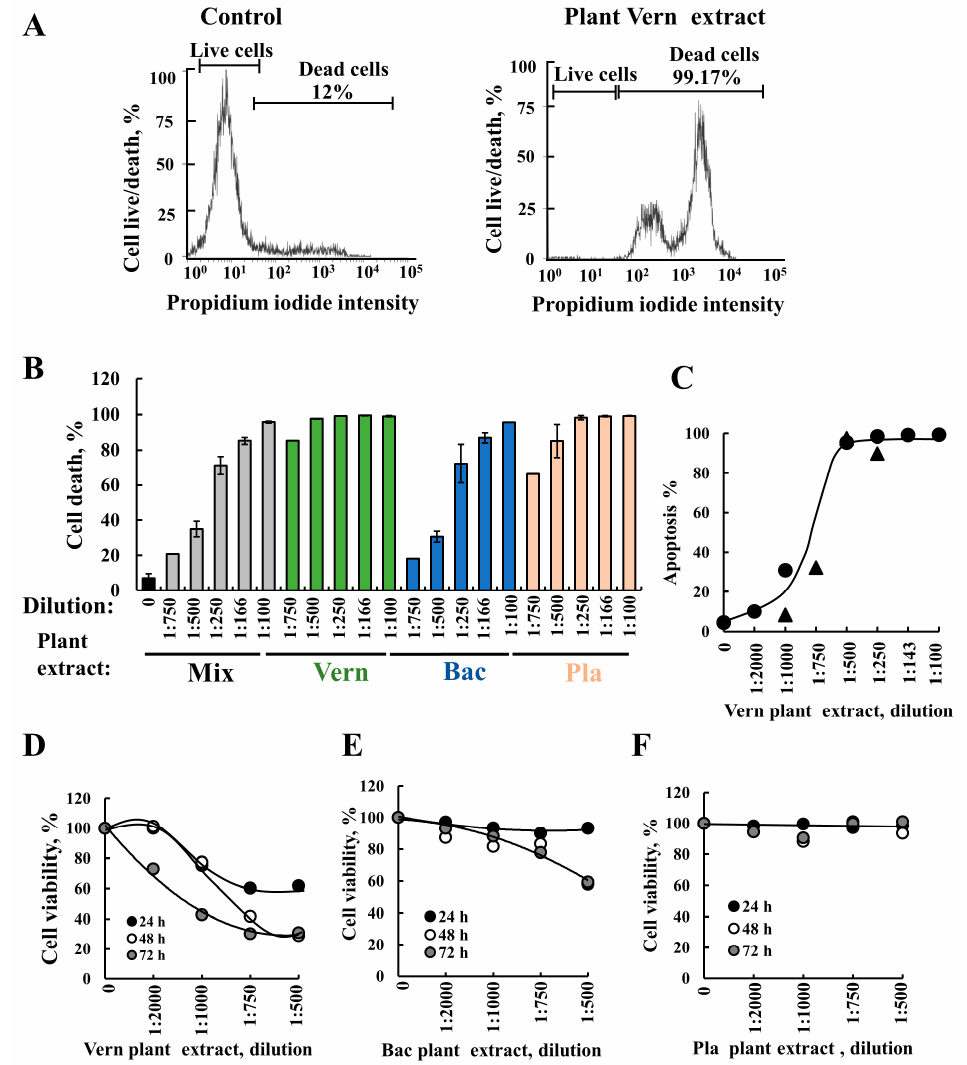
Figure 1. Plant extracts derived from Vernonanthura nudiflora (Vern), Baccharis trimera (Bac), and Plantago major (Pla) inducing apoptotic cell death . Cancer cells, SH-SY5Y, were incubated (24 h) with the indicated dilutions of the ethanolic plant extracts: Vern (Vernonanthura nudiflora), Bac (Baccharis trimera), Pla (Plantago major), or their mixture (Vern+Bac+Pla). ( A ) A representative FACS analysis of propidium iodine (PI)-stained cells showing live and dead cells in the control and cells incubated for 24 h with Vern plant extract (1:500). ( B ) Apoptosis was analyzed in cells incubated with the indicated different dilutions of extract from plant Vern, Bac, or Pla extracts, and death cells were analyzed as in ( A ). The results are the mean ± SEM of three independent experiments. ( C ) SH-SY5Y cells were incubated (24 h) with the indicated dilution of Vern plant extract, and then analyzed for apoptosis using Annexin V/PI staining and FACS. ( ● ) and ( ▲ ) represent results from two different experiments. ( D – F ) SH-SY5Y cell survival as revealed by the XTT assay of cells incubated with different dilutions of the indicated plant extract for 24, 48, or 72 h. To determine whether the observed cell death induced by Vern was apoptosis, we analyzed apoptosis by Annexin V/PI and via FACS (Figures 1C and S1). The results show that Vern extract induced apoptotic cell death.